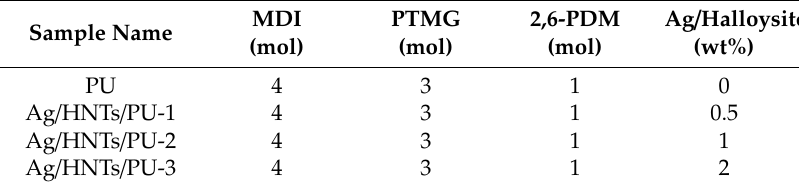
Table 1. Experimental formula of Ag / HNTs /